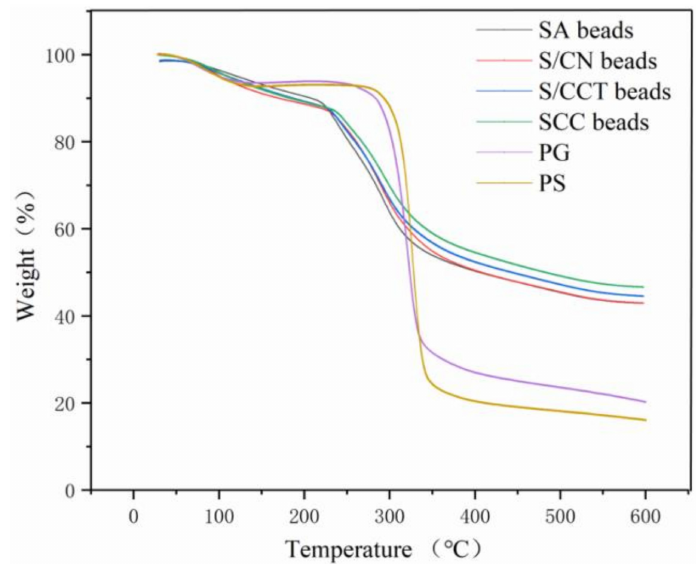
Figure 6. TG curves of PS, PG, SA beads, SCN beads, SCT beads, and SCC beads.